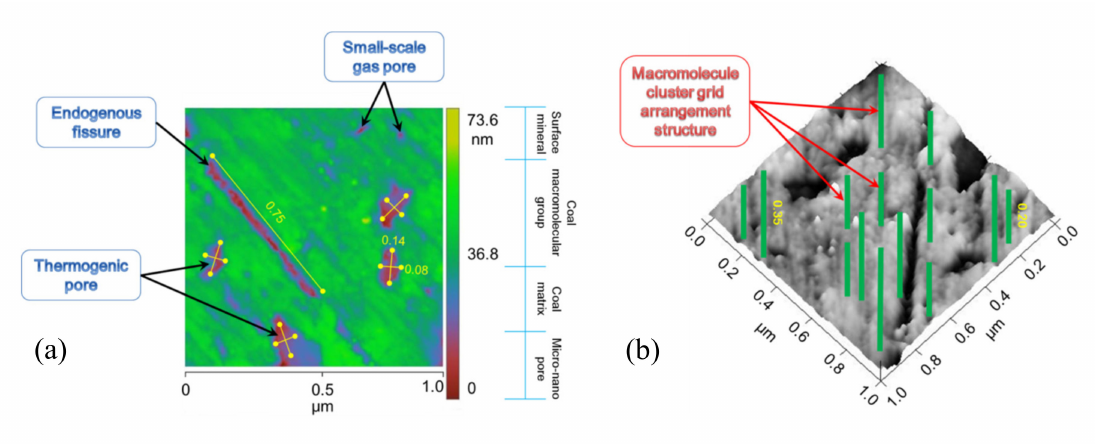
Figure 3. ( a ) 2D gridded arrangement structure formed by coal macromolecular groups. Green regions are nanowires formed by coal macromolecular accumulation, and dark regions between adjacent nanowires are intermolecular pores and fractures; ( b ) is a three-dimensional image of ( a